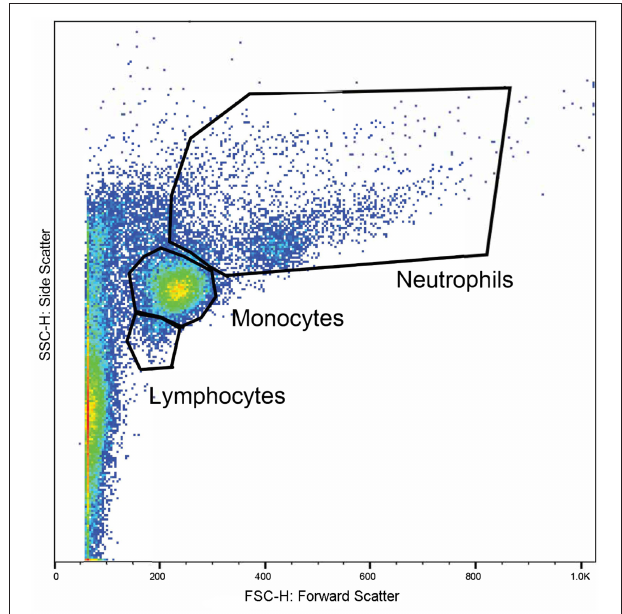
FIGURE 1 | A representative plot displaying the flow cytometry scatter properties of leukocytes in one sample. The forward scatter (x-axis) corresponds to size of the cells and the side scatter (y-axis) corresponds to the cells’ granularity. Regions were gated around clusters of cells corresponding to the expected locations for lymphocytes, monocytes, and